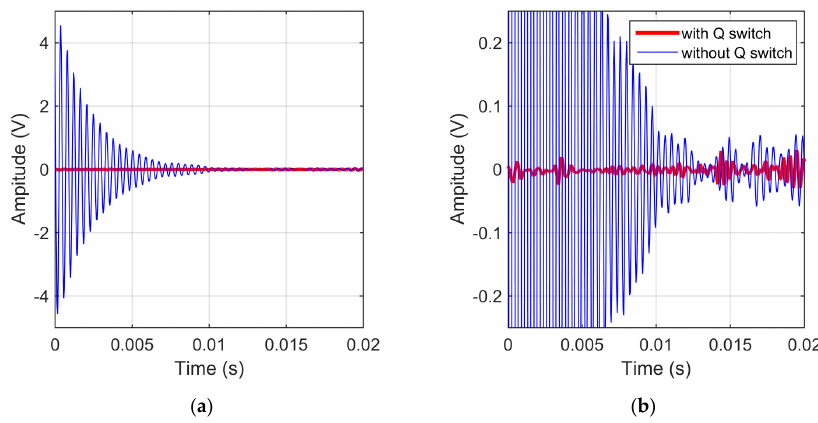
Figure 7. Ringing and suppressed ringing (the blue curve is the ringing collected by instrument, the red curve is normal picked up without ringing). ( a ) Ringing within 20 ms; ( b ) Ringing damping.